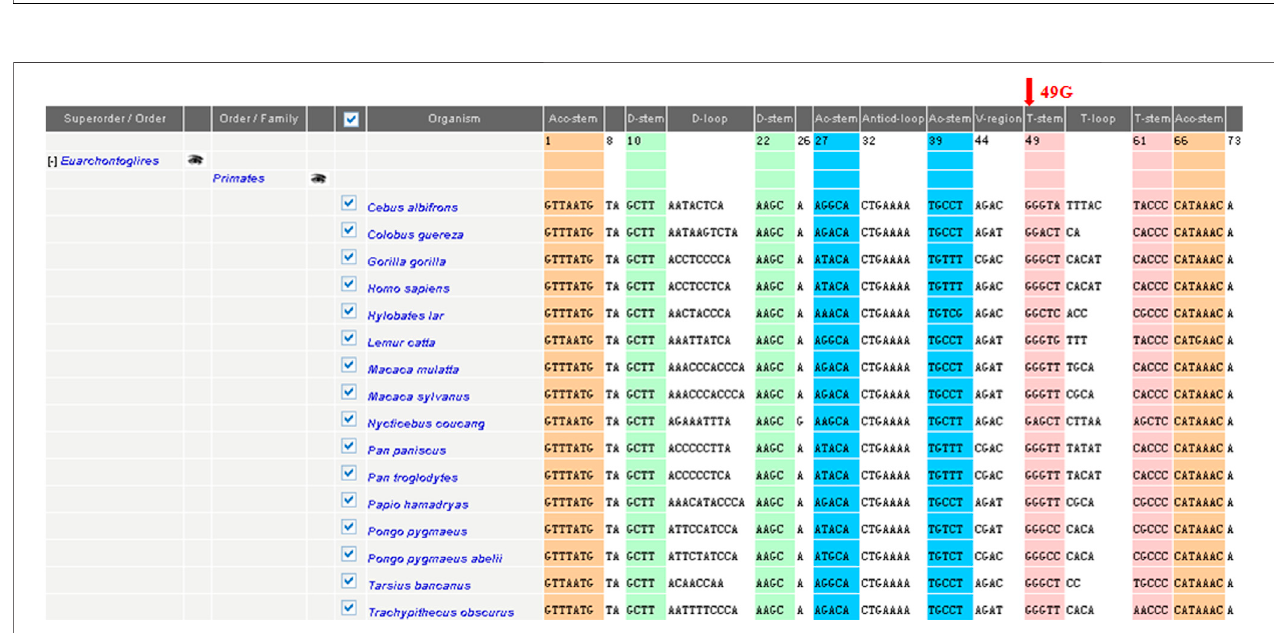
FIGURE 3 | Sequence alignment of the mitochondrial tRNA Phe gene in different species. Arrow indicates the conservation of the G nucleotide at position 49 throughout species. The conservation index (CI) at position 49was 100% in 17 vertebrates, by comparing the human nucleotide variants with other 16 vertebrates.